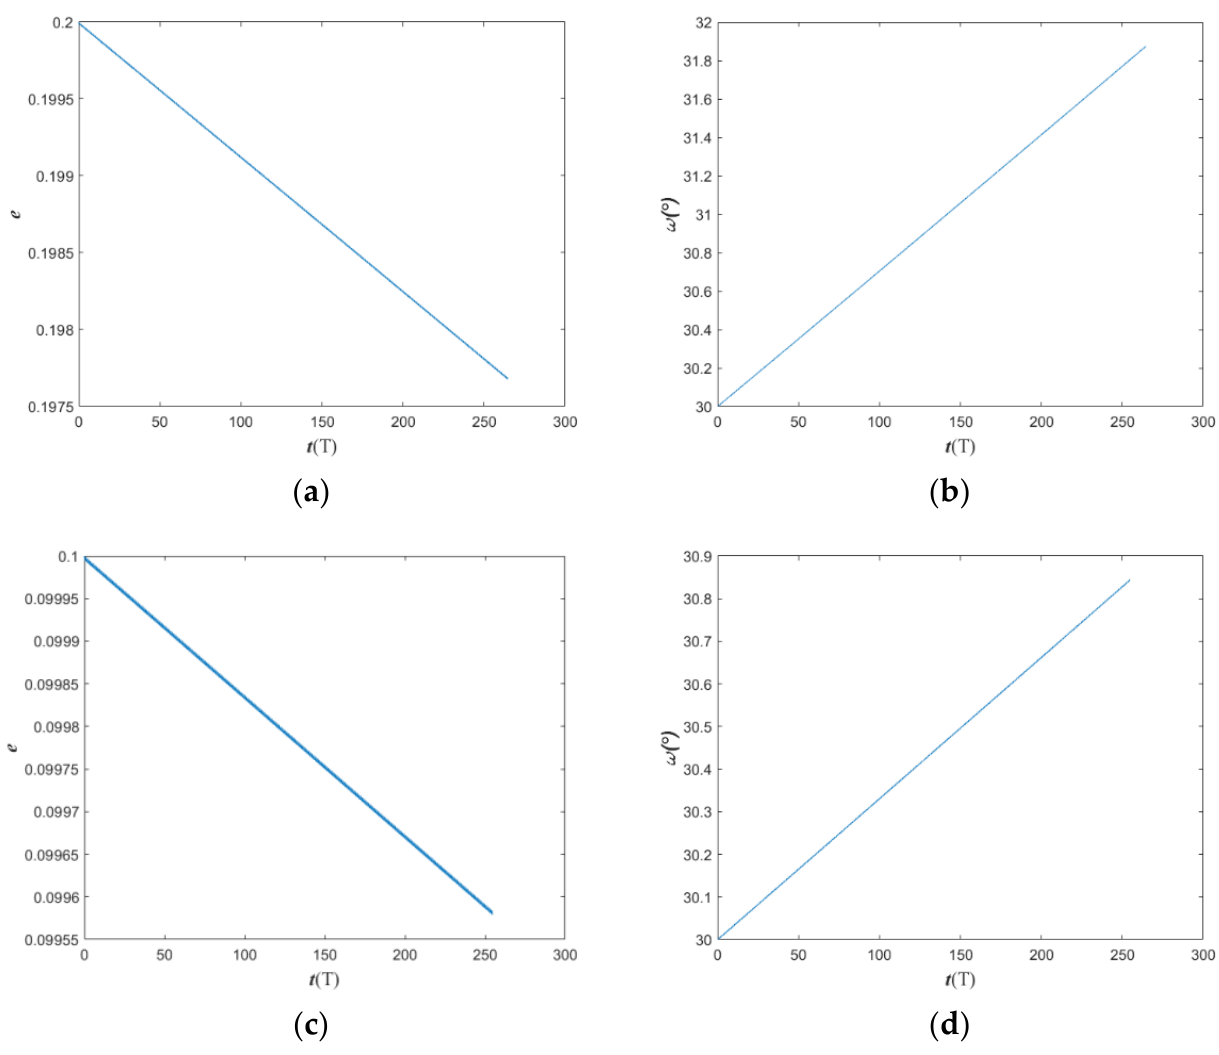
Figure 7. Evolution of e and ω over 250 T of the critical inclination orbit: ( a , b ) a = 492.171 km, e = 0.2, i = 63.499 deg. ( c , d ) a = 522.580 km, e = 0.1, i = 63.519 deg.